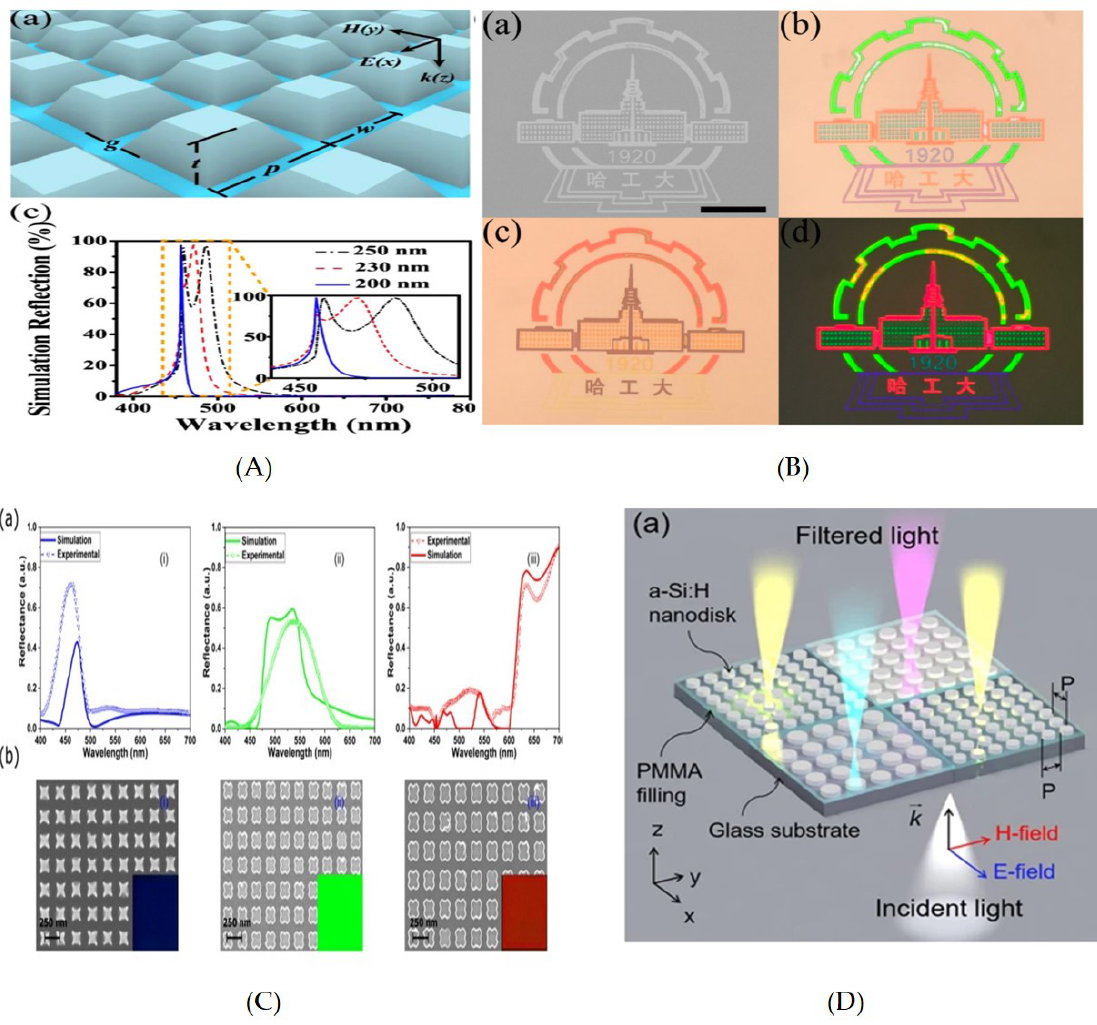
Figure 8. ( A ) Schematic diagram of TiO 2 based color filter, the reflection spectra shows dependence of filter on the device dimensions (here the width of the bottom face w is varied from 200 to 250 nm). ( B ) Color image printing is exhibited with the top view SEM image of the logo with transmission and reflection colorful images under bright field microscope. Reproduced with permission of